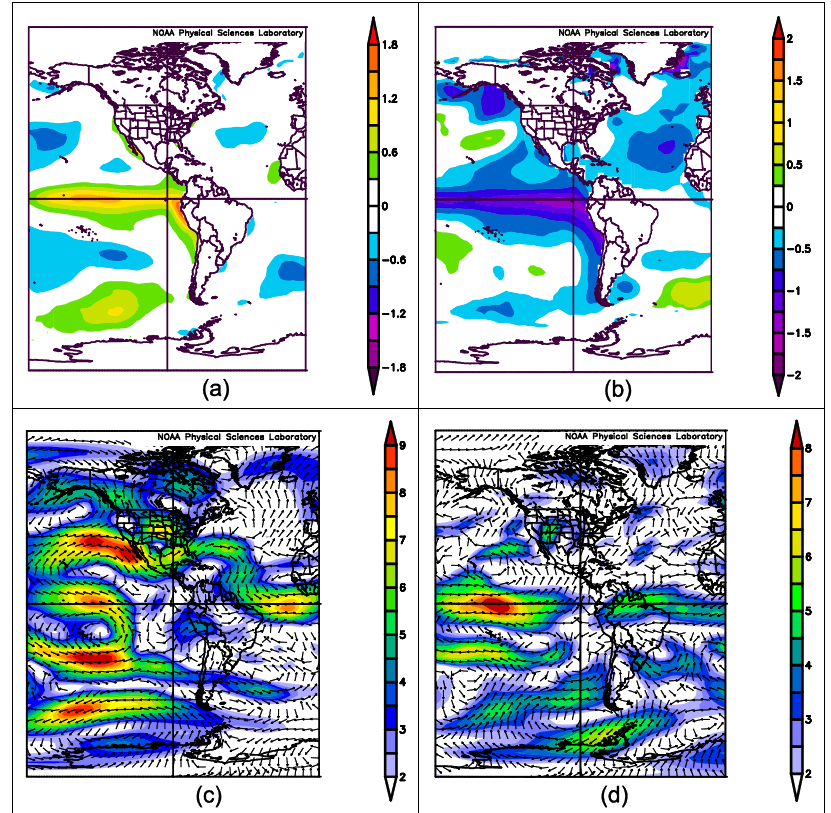
Figure 4. Composite anomalies of Sea Surface Temperature (SST) for extreme ( a ) warm years in February and ( b ) cold years in august. Composite anomalies of winds at 200 hPa associated with extreme ( c ) warm years in February and ( d ) cold years in August in Metropolitan Lima. Anomalies in °C for the SST and m/s for winds, their ranges are shown in the vertical color bars to the right of each figure. Data are from the NCEP/NCAR Reanalysis. Climatology 1981 – 2010. Source: NOAA Physical Sciences Laboratory.